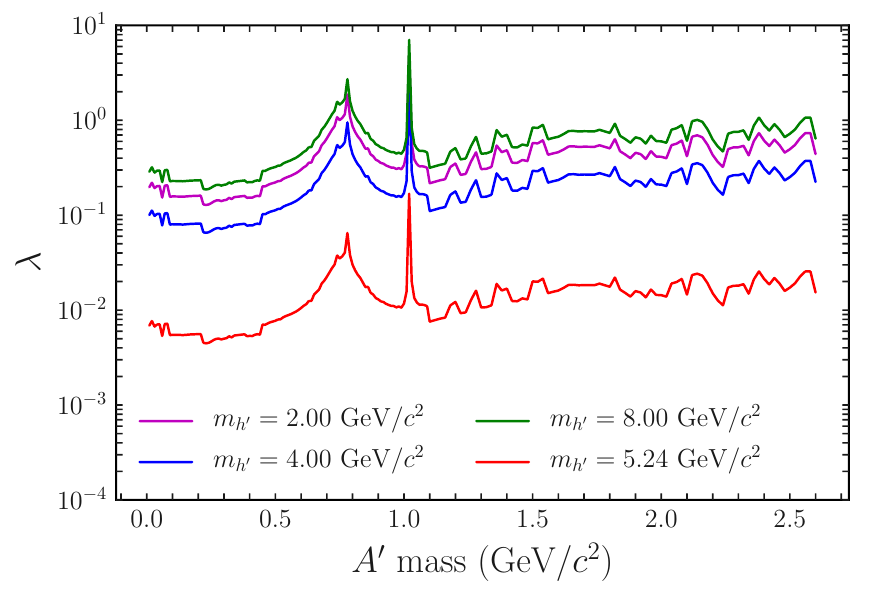
Figure 6 . 90% upper limits of the Higgs portal coupling ( λ ) versus the dark photon mass for a 2 . 00 , 4 . 00 , 5 . 24 , 8 . 00 GeV /c 2 dark